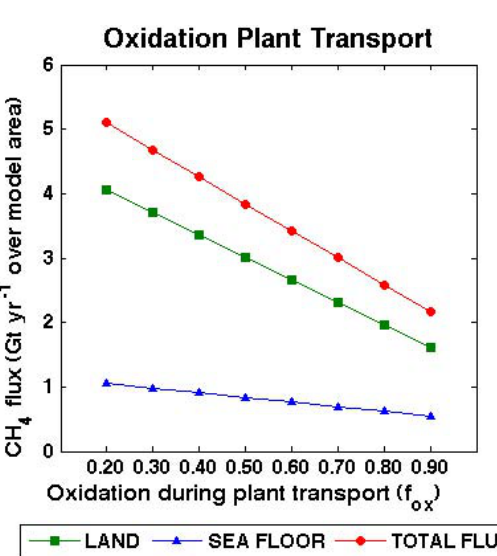
Fig. 3. The effects of plant transport factor V transp with fixed (FIXEDWT) and modelled (MODELWT) water table values. The plant transport clearly interacts with the water table model applied. For FIXEDWT, an increase in CH 4 flux occurs with increasing V transp , for MODELWT a